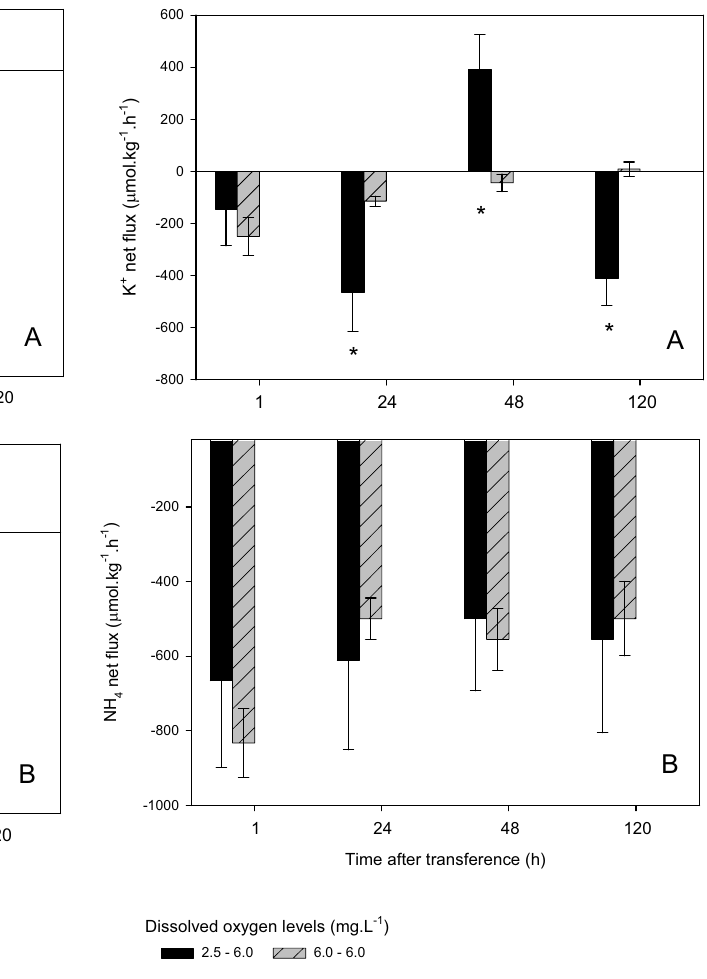
Fig. 3. Na + (A) and Cl - (B) net fluxes of silver catfish juveniles acclimated to 2.5 (2.5 – 6.0) or 6.0 (6.0 – 6.0) mg.L -1 dissolved oxygen levels for three weeks and transferred to aquaria with 6.0 mg.L -1 dissolved oxygen levels. Data expressed as mean ± SEM. Positive values indicate net influxes, and negative val- ues net effluxes. Mean value of Cl - flux at 24 h in juveniles transferred to 6.0 mg.L -1 is too small to be seen in the figure. * significantly different from juveniles transferred to 6.0 mg.L -1 at the same time after transference by one-way ANOVA and Tukey test (P < 0.05).